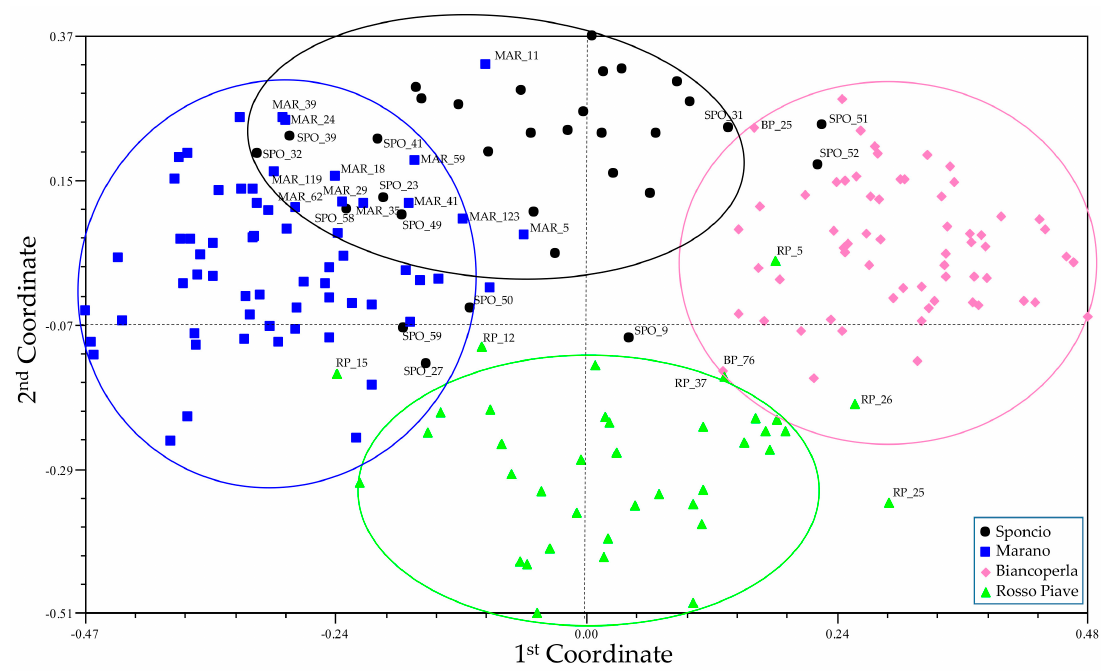
Figure 1. Two-dimensional centroids derived from genetic similarity estimates computed among the 197 accessions in all possible pairwise comparisons using the SSR marker data set. Only the names of those genotypes with unclear membership to one of the four subgroups are reported.